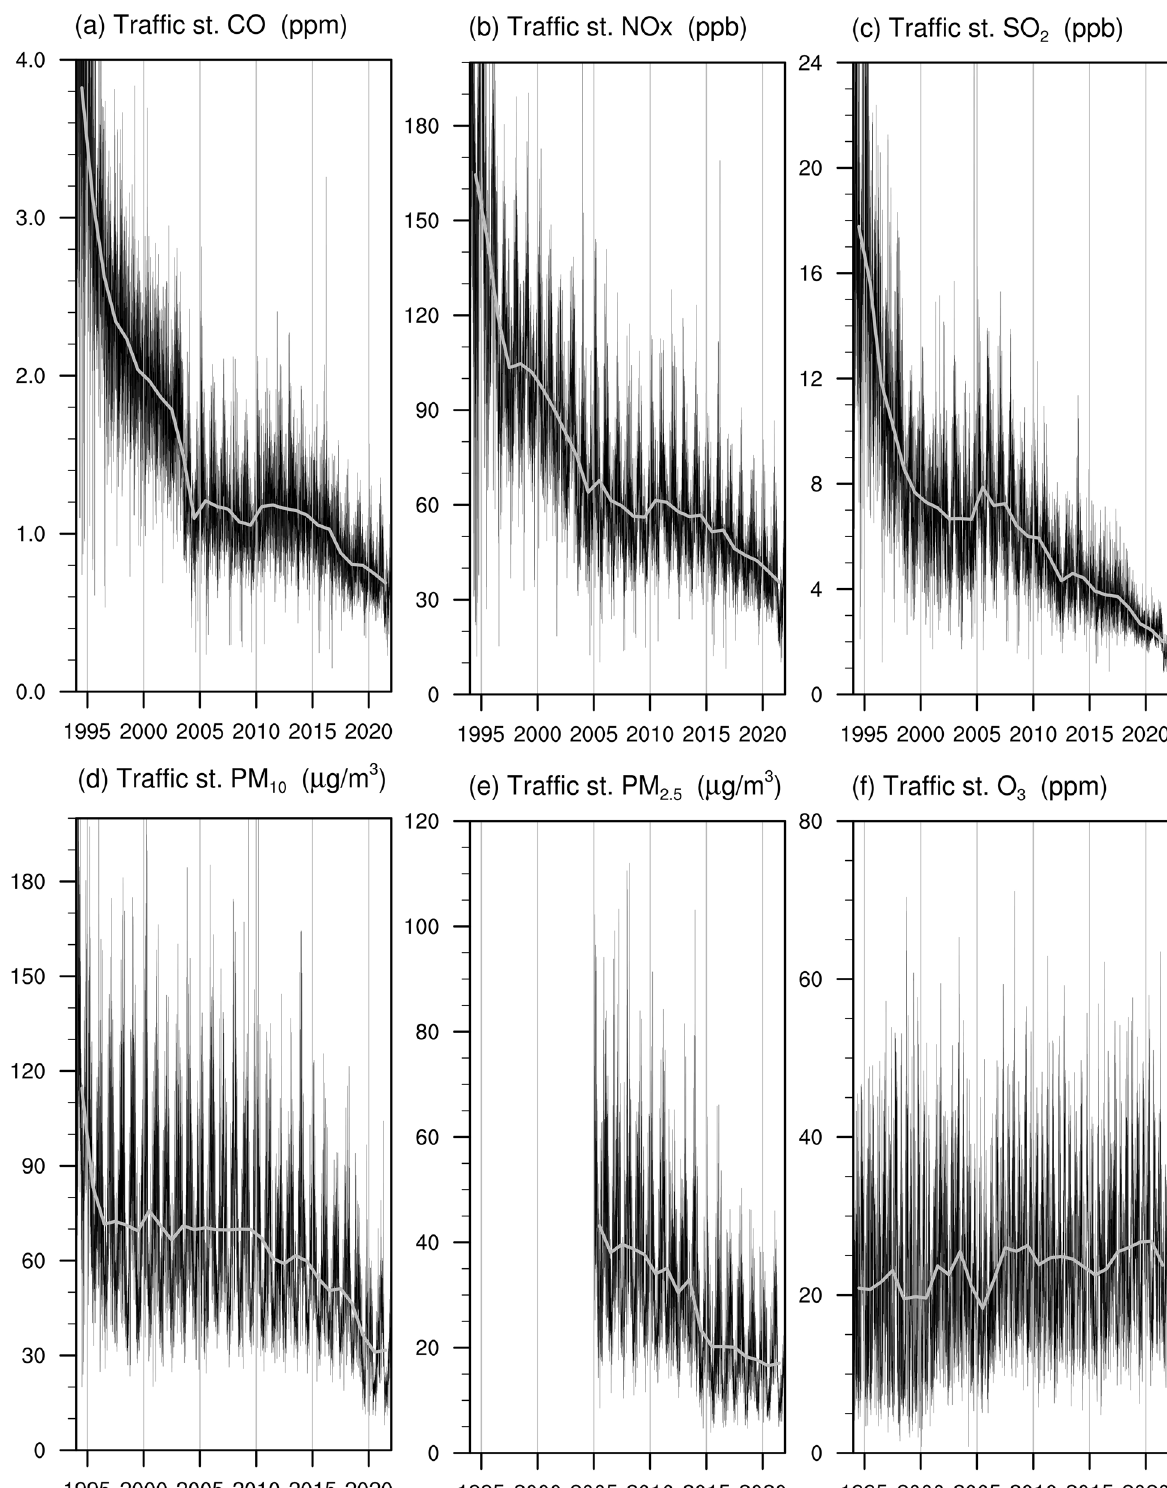
Fig. 3 Same as Fig. 2 but monitored by the traffic